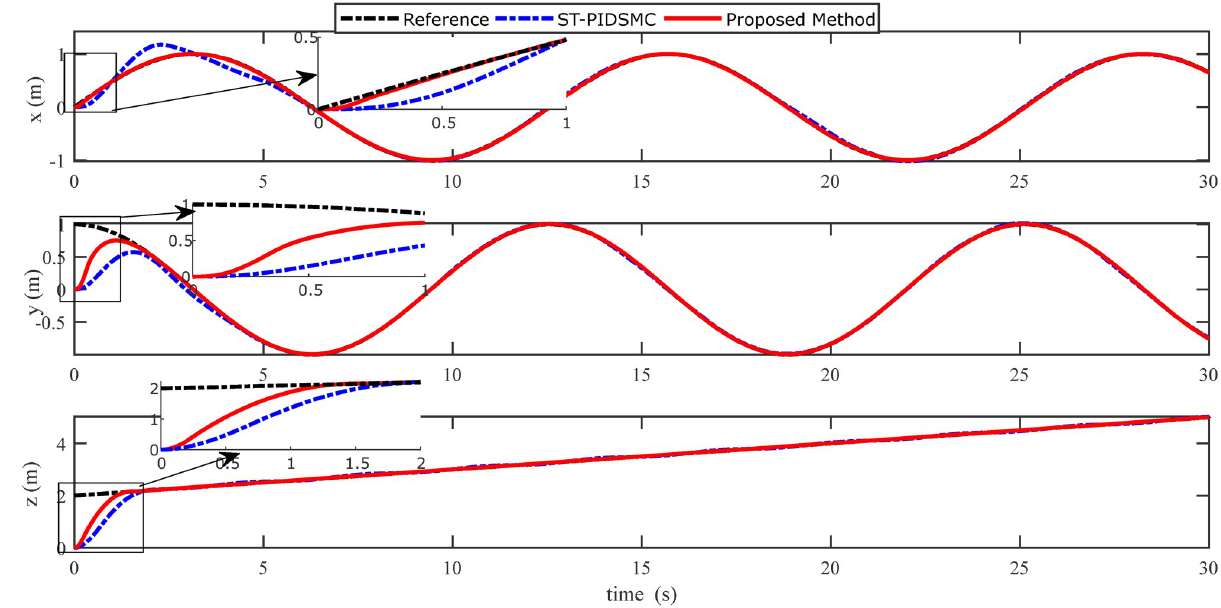
Fig 14. Results of the position under the proposed and ST-PID-SM controllers.